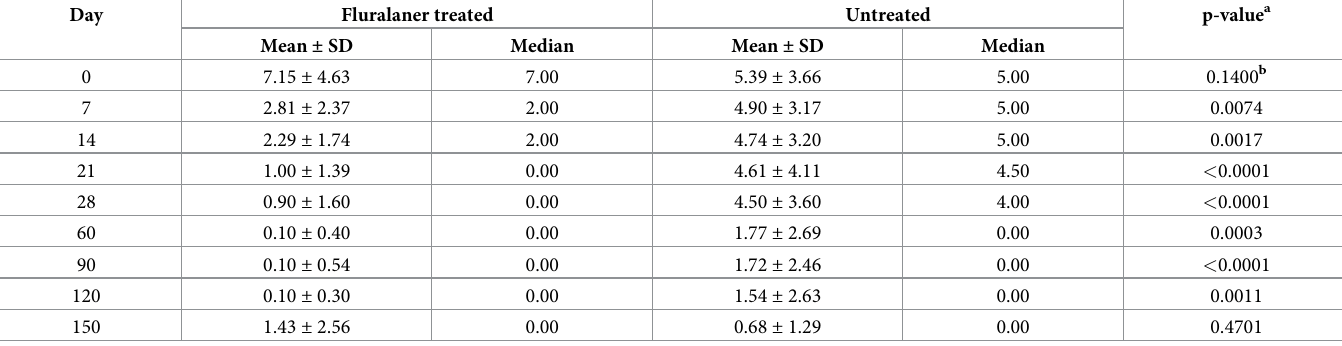
Table 6. Clinical scores as measured by mean SCADT (data by inspection time point by study group and p-values) in fluralaner treated and untreated dogs natu- rally exposed to Tunga penetrans .